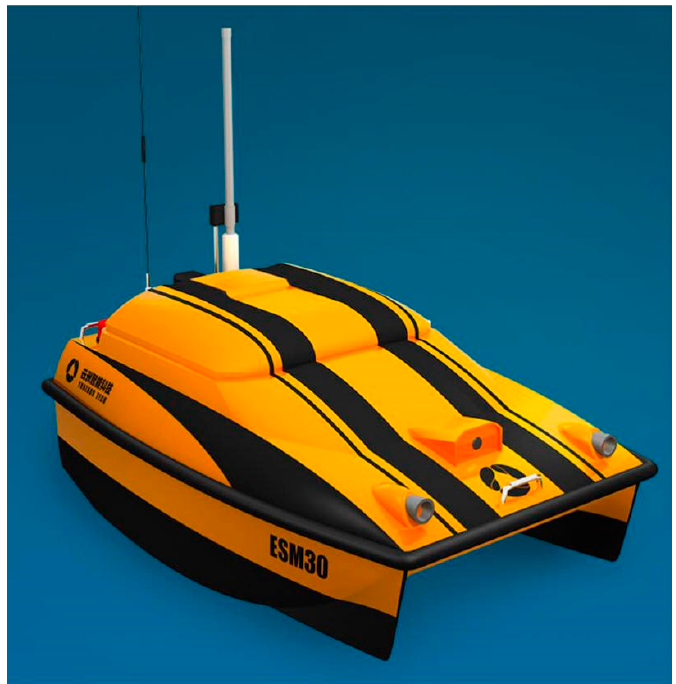
Figure 8. ESM30 autonomous water sampling and monitoring boat (Source: YUNZHOU TECH).